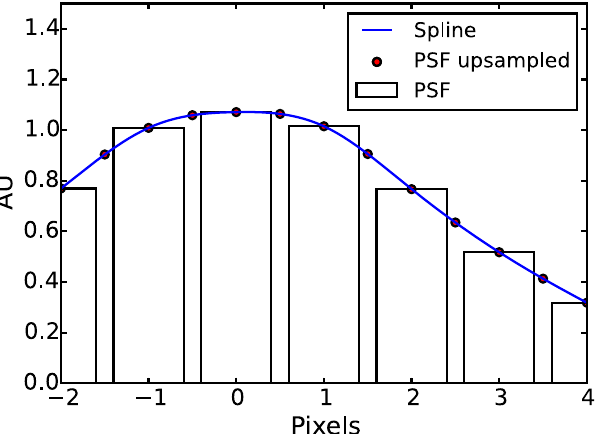
Figure 1. 1D Spline example. Each cubic spline interval (the blue line) is determined such that itself and its first derivative are continuous across the red points which are the interval boundaries. The red points are calculated by up-sampling the measured PSF (grey bars) by a factor of two using 3 rd order spline